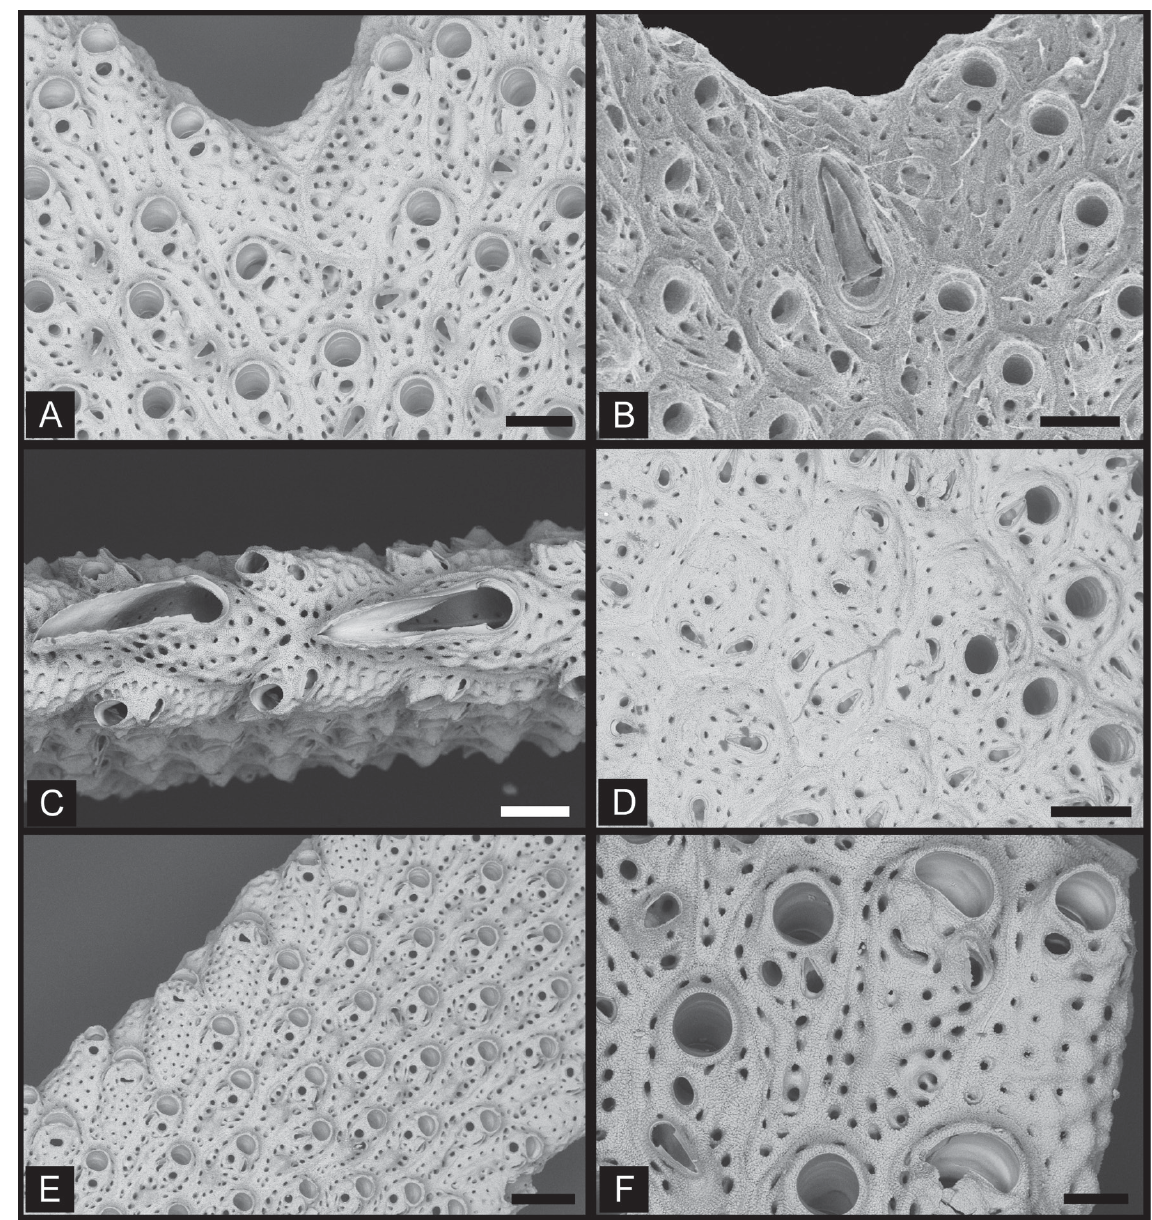
Fig. 5. Adeonella jahanai sp. nov. A . Branch bifurcation lacking vicarious avicularaia (NsMT- Te889, okinawa). B . Branch bifurcation with vicarious avicularium (NsMT-Te749, off Yakushima). C . Vicarious avicularia on side of branch (NsMT-Te889, okinawa). D . old part of branch showing autozooids and kenozooids (NsMT-Te889, okinawa). E . Gonozooids at periphery of branch (NsMT- Te889, okinawa). F . Gonozooid at periphery of branch (NsMT-Te889, okinawa). seM images. scale bars: A– D = 200 μm; E = 300 μm; F = 100